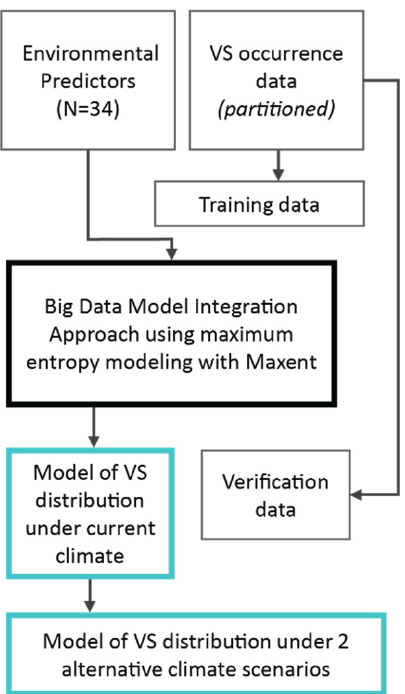
Figure 1. Diagram of the workflow. Products are shown in cyan.